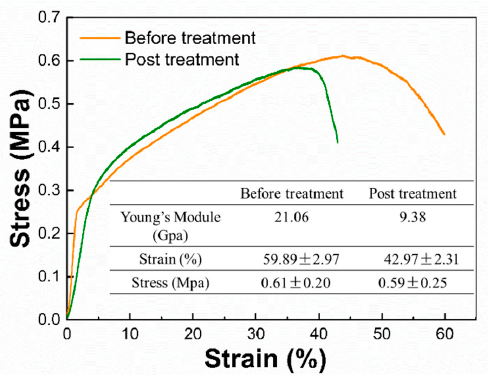
Figure 10. Stress − strain curves of the of PLLA fi brous membranes before and after post-treatment.